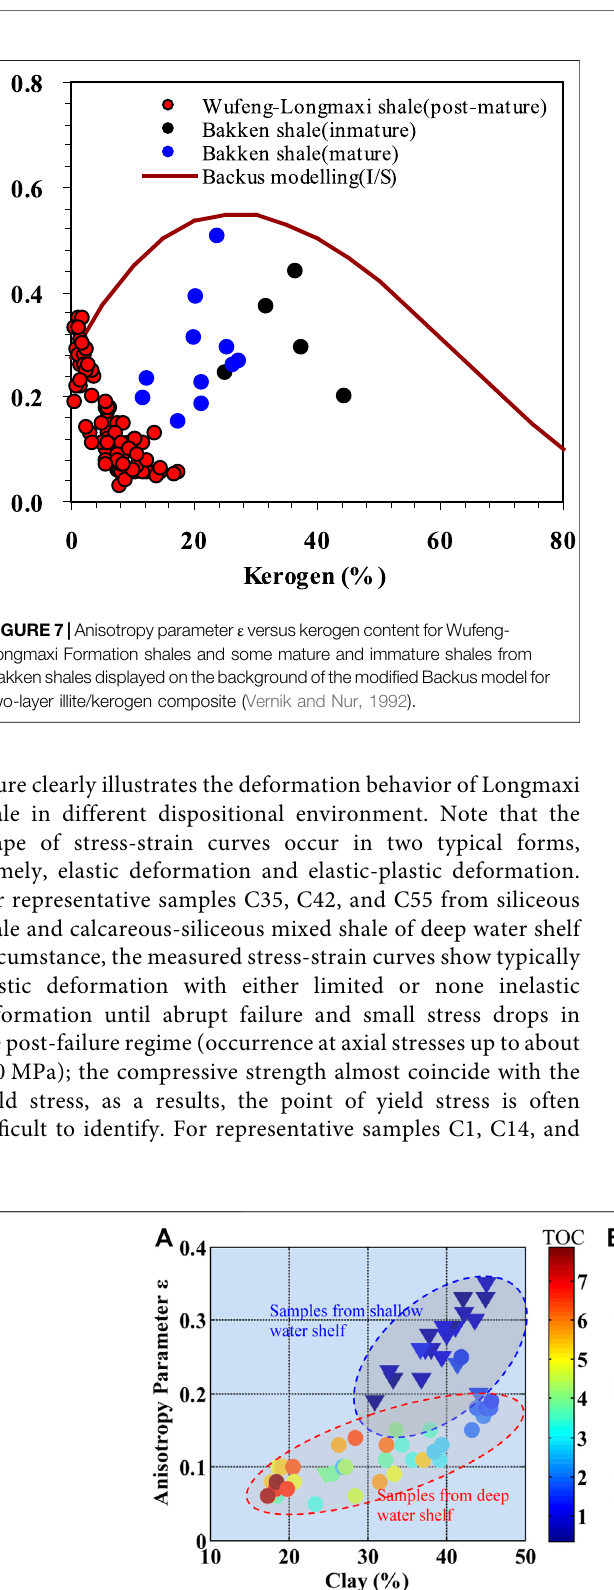
Frontiers in Earth Science |